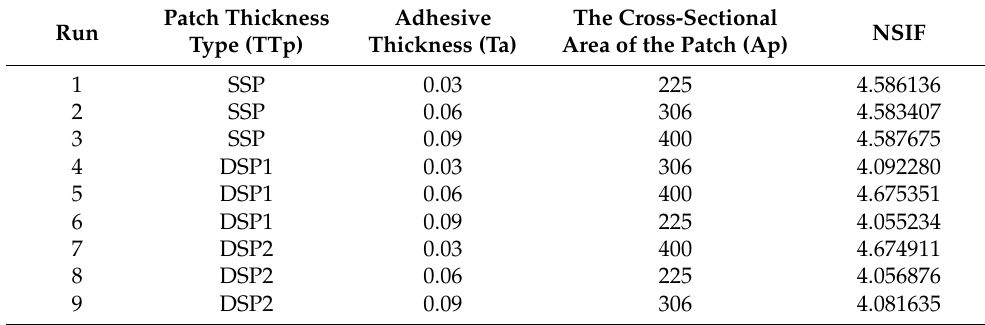
Table 5. Orthogonal array (OA) L 9 with NSIF results.